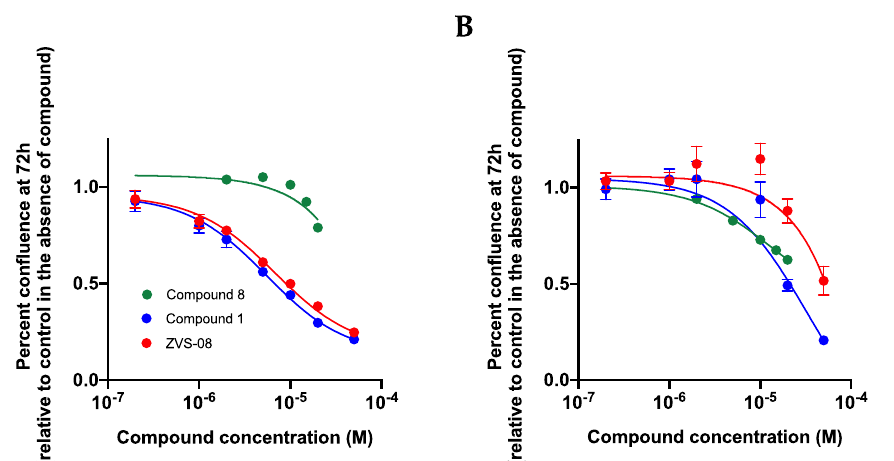
Figure 14. Effects of ZVS-08 and compounds 1 and 8 on the growth of MCF-7 ( A ) and Panc1 cells ( B ). ZVS-08 and compound 1 inhibited the growth of MCF-7 cells with IC 50 of 6.8 (95% CI: 5.14– 9.38 µM) and 5.48 µM (95% CI: 4.51–6.76 µM). Compound 8 was ineffective at the concentrations tested. None of the compounds inhibited the growth of Panc1 cells significantly at concentration below 10 µM, and an IC 50 could only be determined for compound 1 (over 30 µM).